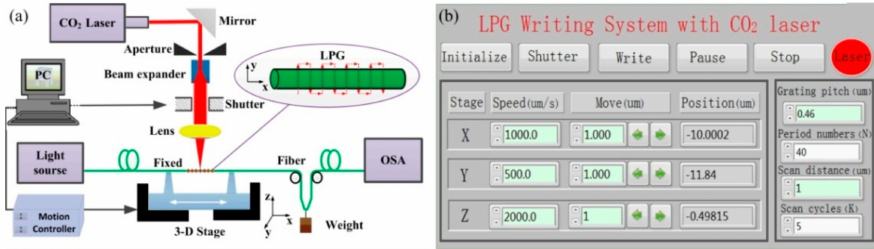
Figure 1. ( a ) Experimental setup and ( b ) operation interface of the standard long period fiber grating (SLPFG) fabrication system by using CO 2 laser heating technique